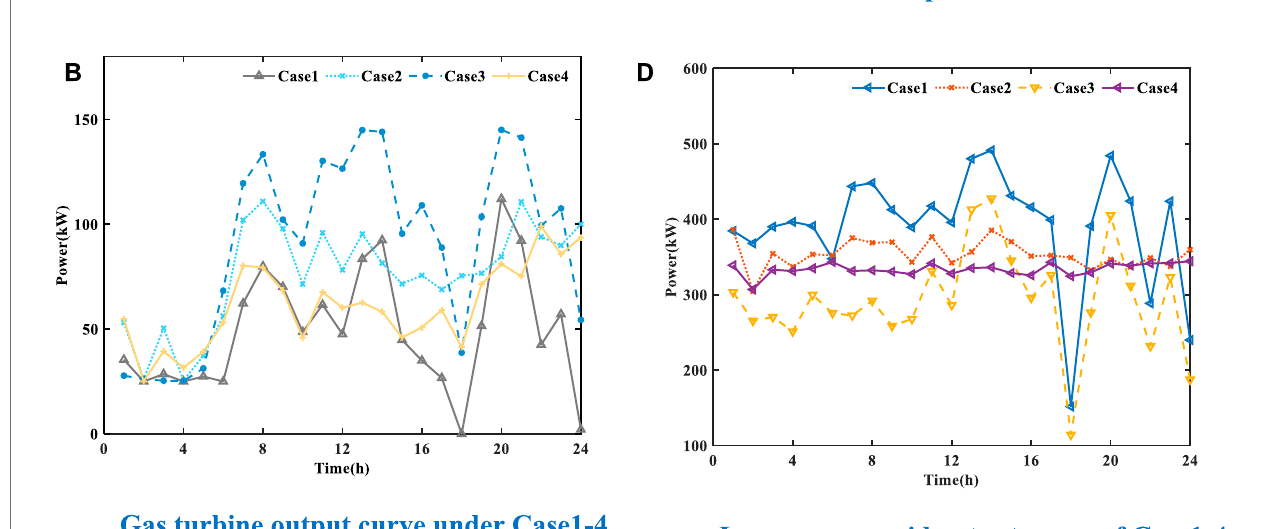
Frontiers in Energy Research |